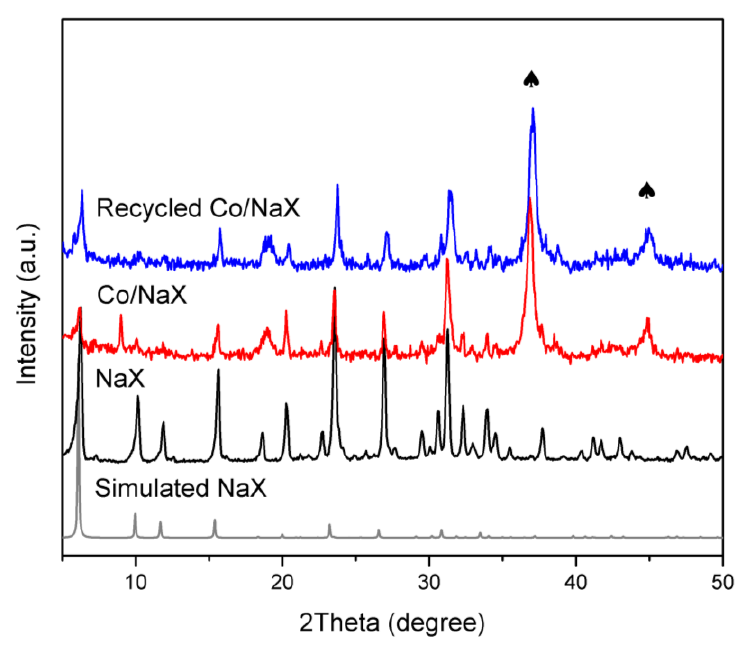
Figure 3. Powder XRD of the catalysts. Cobalt oxide peaks are denoted by ♠ ️ .